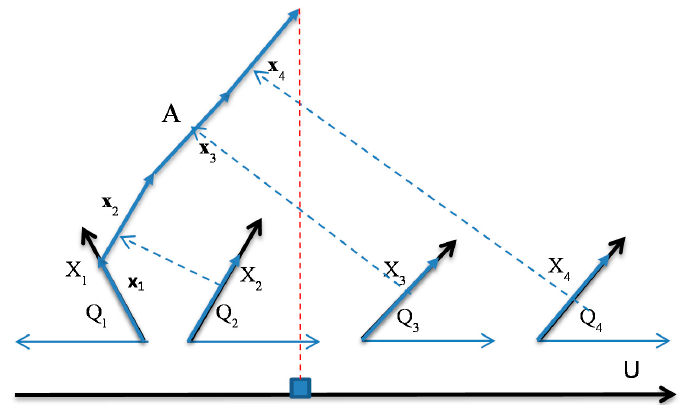
Figure 1. 4-D point A = (1,1,1,1) in GLC-L coordinates X 1 – X 4 with angles (Q 1 ,Q 2 ,Q 3 ,Q 4 ) with vectors x i shifted to be connected one after another and the end of last vector projected to the black line. X 1 is directed to the left due to negative k 1 . Coordinates for negative k i are always directed to the left.